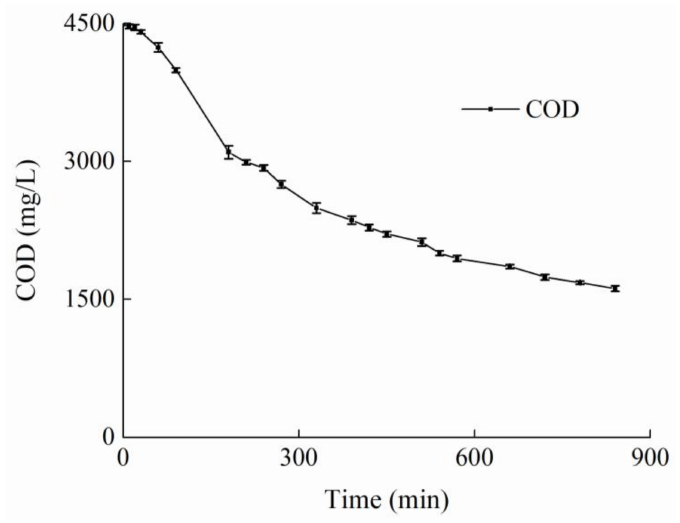
Figure 5. Treatment of wastewater with high salinity by ozone MNBs.